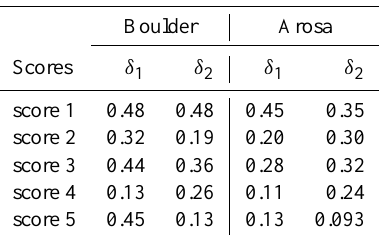
Table 2. Estimates of variance component parameters δ 1 and δ 2 in Eq. (10). The parameters shows the magnitude of seasonal pattern in the variance of the